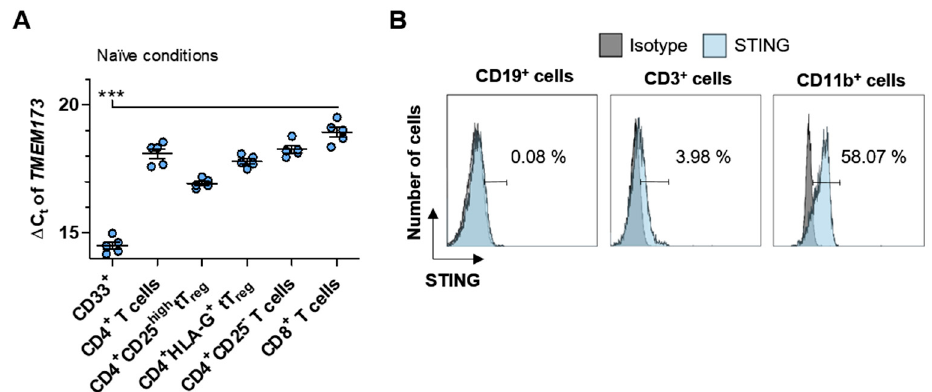
Figure 2. Human myeloid cells show a higher expression of STING than lymphoid cells. ( A ) Illustrated are the expression analysis of TMEM173 in CD33 expressing myeloid cells and di ff erent human T cell subpopulations. All cell populations were isolated from peripheral blood mononuclear cells (PBMC) of healthy donors (HD), and each symbol represents the resulting ∆ C t value of an individual HD. ( B ) Percentage of STING protein expression in comparison to its corresponding isotype control is shown for CD19 + (left panel), CD3 + (middle panel), and CD11b + (right panel) cells as one representative result of 5 independent flow cytometric analyses. Each symbol ( A ) represents an individual HD. Data in ( A ) were analyzed by one-way ANOVA, and the level of significance was labeled as *** p < 0.001. Abbreviations: Human leukocyte antigen G (HLA-G) .